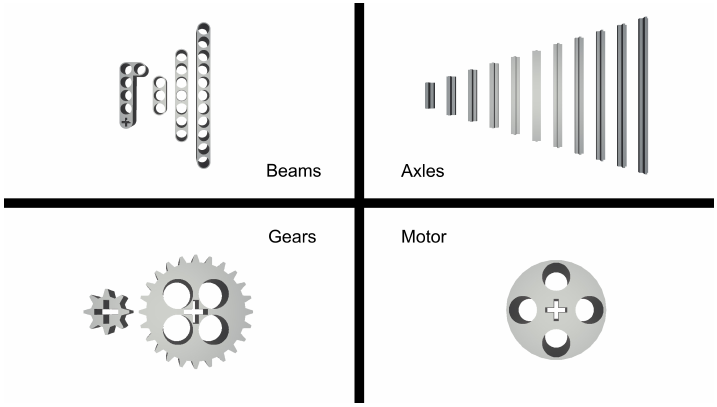
Figure 1. Types of mechanical parts in our